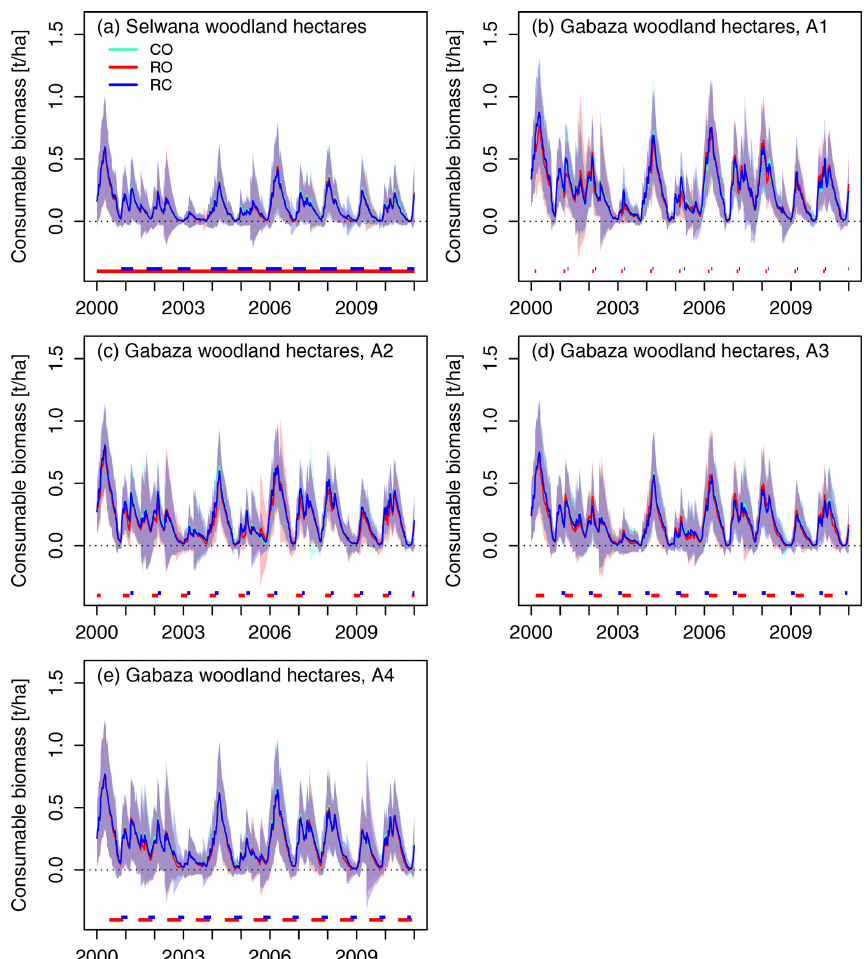
Figure 11. Temporal dynamics of average consumable grass biomass on simulated woodland hectares (living and dead standing grass leaf biomass, and reproductive biomass, reduced by the minimum amount that is not available to grazers, i.e., 0.3th − 1 for living and dead grass biomass, respectively, and 0.1tha − 1 of reproductive biomass). Lines denote the mean across all simulated hectares, and shaded areas show the standard deviation. The horizontal lines at the bottom of the panels denote the respective animal presence times for the RO and RC